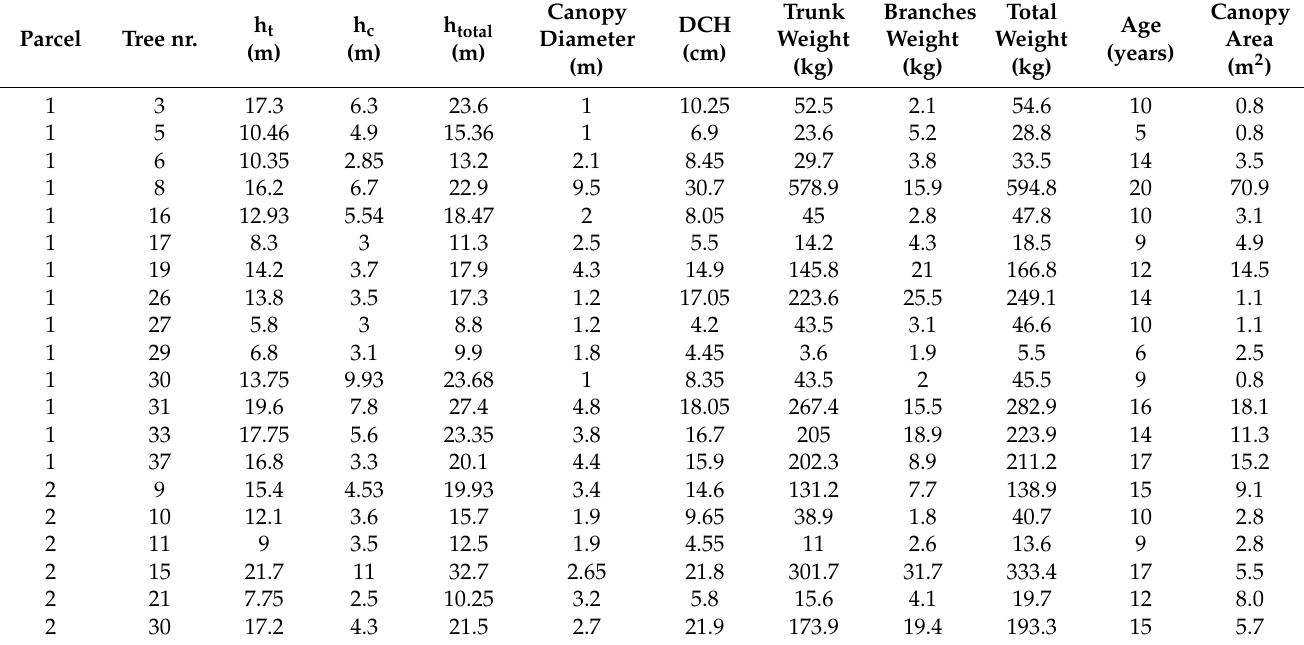
Table 3. Data collected and calculated for selected